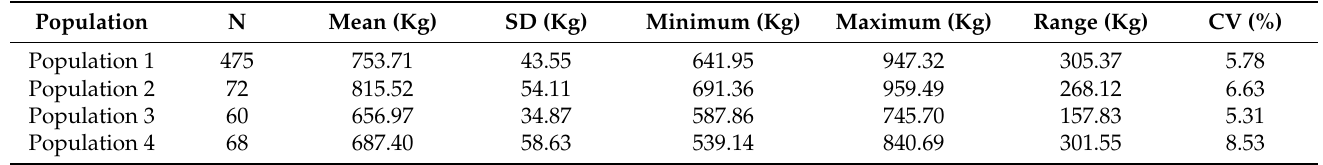
Table 1. Summary of basic statistics of yields of the four populations.